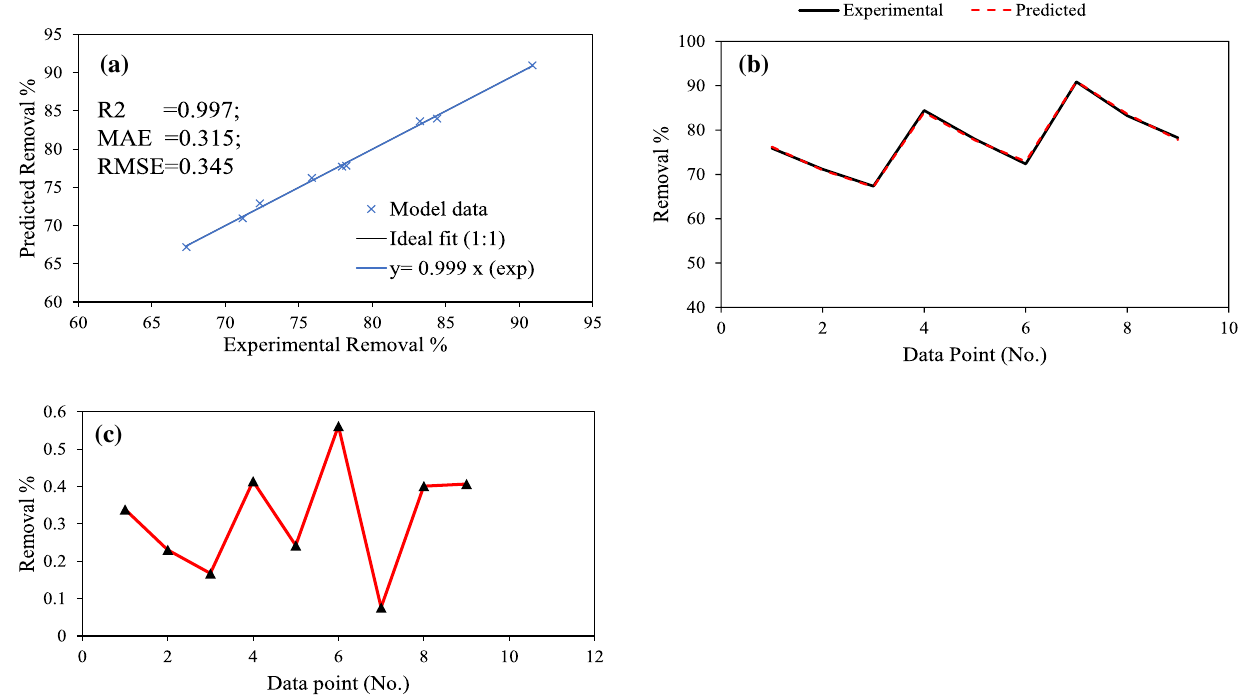
Fig. 3 Performance of the R H 2 O 2 model a experimental versus predicted slope, b tracing of experimental values by the predictions and c error